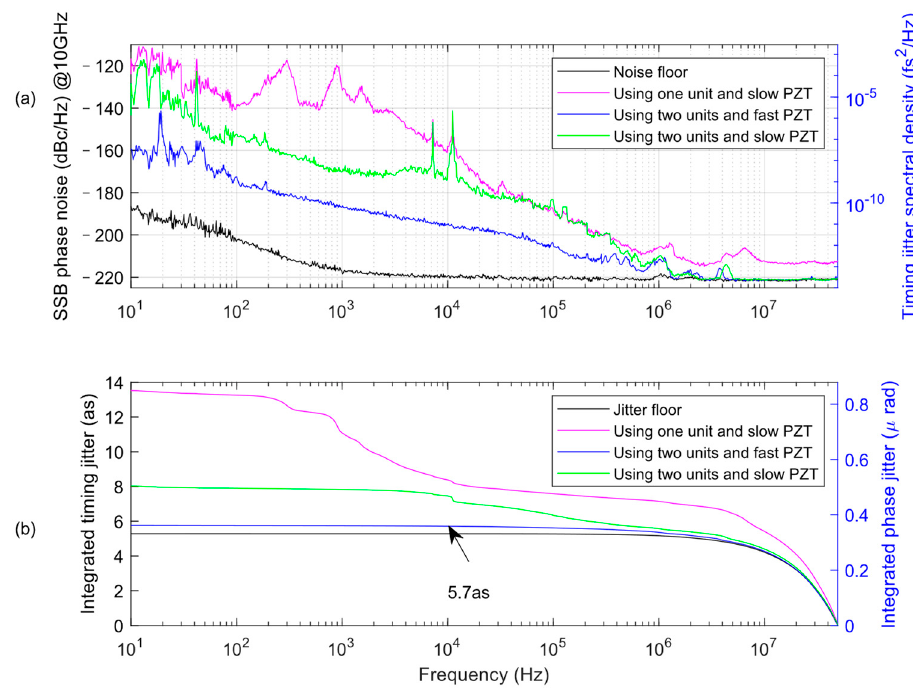
Figure 6. Single-sideband phase noise ( a ) and integrated timing jitter ( b ). Traces have been scaled from the fundamental 99 MHz to 10 GHz for comparison.